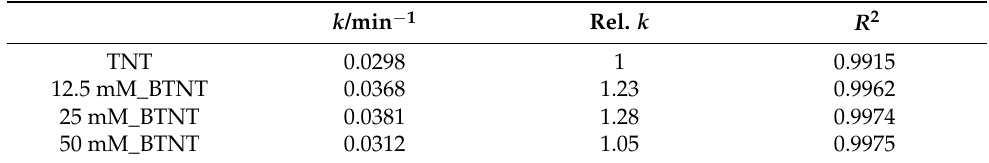
Table 4. Photocatalysts overview with obtained corresponding rate constants k (pseudo-first order kinetic